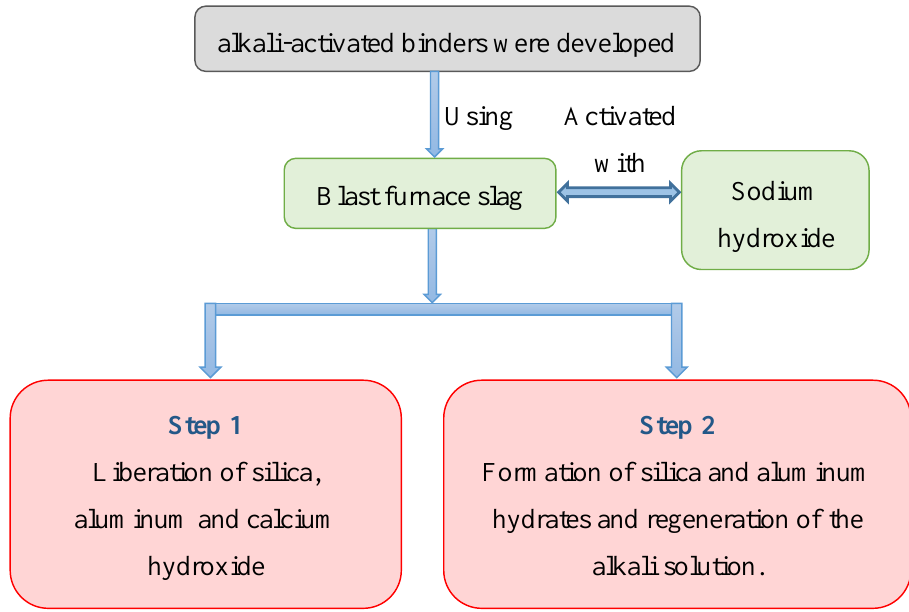
Figure 1. Alkali- activated binders’ first development by Purdon in 1940 [5]. Figure 1. Alkali-activated binders’ first development by Purdon in 1940